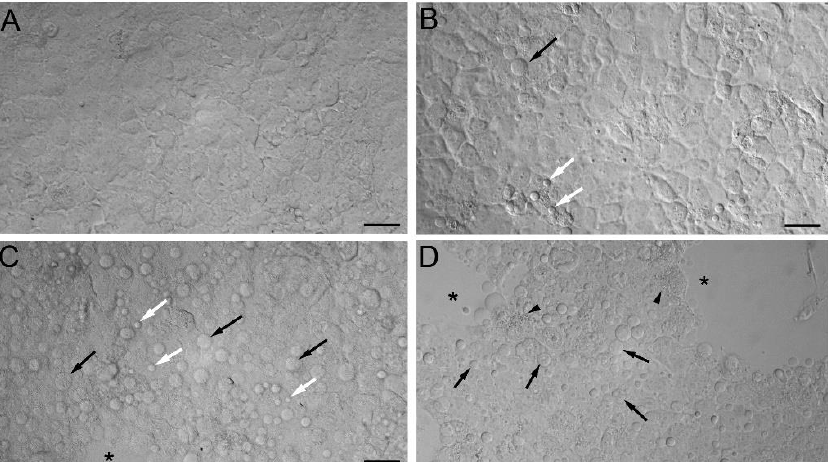
Figure 6. Morphological analyses of BeWo cells were exposed to MeHg-Cys. BeWo cells were exposed to buffer ( A ) or 100 µ M ( B ), 250 µ M ( C ), or 500 µ M ( D ) MeHg-Cys for 30 min at 37 ◦ C. Cells exposed to buffer ( A ) exhibited normal morphology while cells exposed to MeHg exhibited blebs (white arrows) and detaching cells (black arrows). Gaps (*) in the monolayer were evident in cells exposed to 250 and 500 µ M MeHg-Cys. Small organelles (arrowheads) were identified in the cytoplasm of cells exposed to 500 µ M MeHg-Cys. Images shown are representative of 3 experiments performed in triplicate. Scale bar = 40 µm.